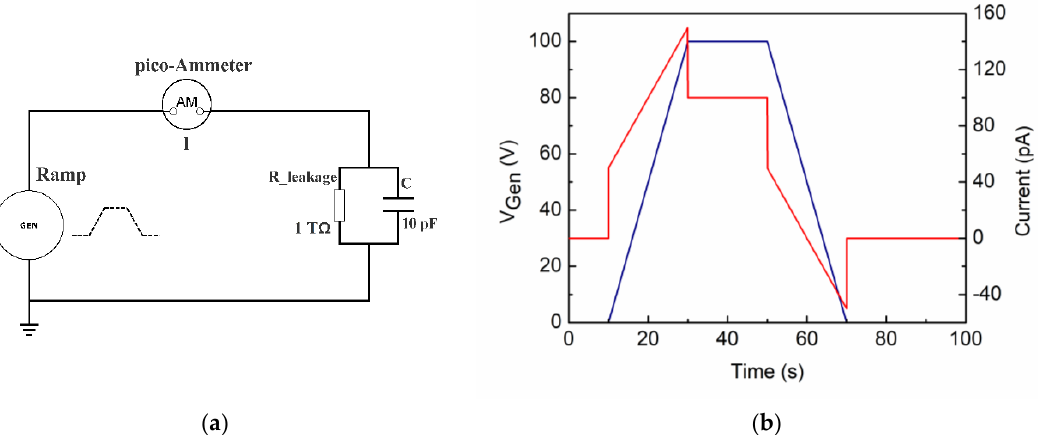
Figure 3. ( a ) Simulated circuit with a capacitor (10 pF) in parallel to a resistor (10 12 Ohm); a 50-Ohm resistor (not shown) was also added to simulate the output impedance of the generator. ( b ) The applied voltage ramps up/dw (+/− 5 V/s) are shown in blue (left scale), and the simulated current intensity is shown in red (right scale).